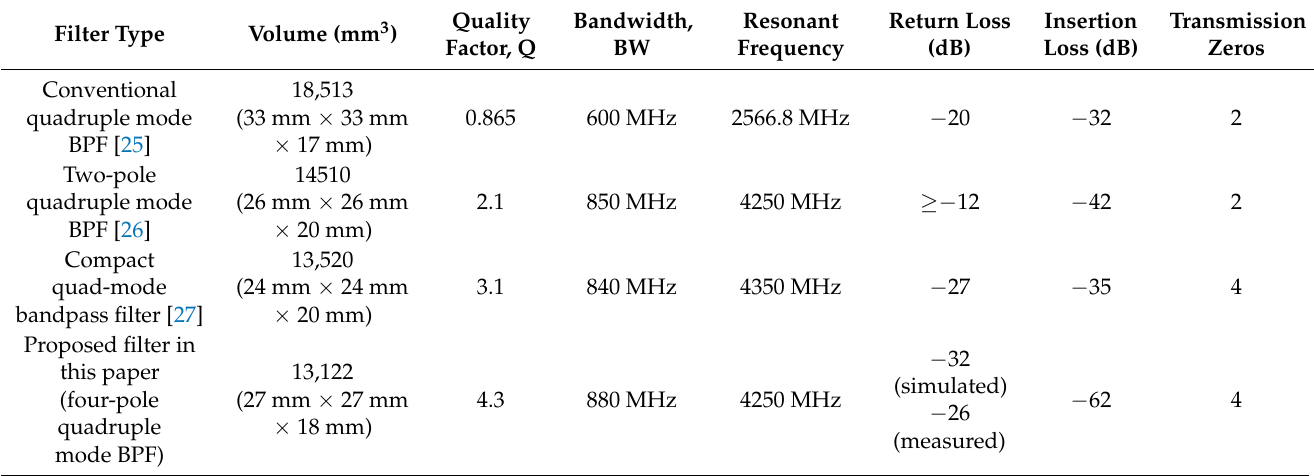
Table 2. Comparative analysis of the conventional and proposed multimode resonating filters.